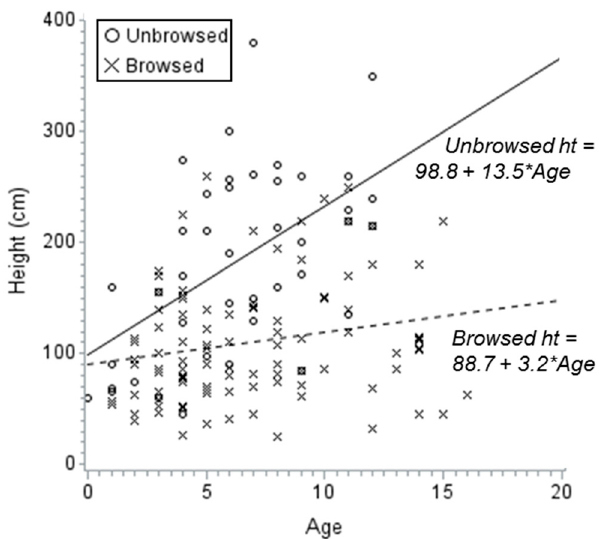
Figure 3. Height and age relationship for unbrowsed (solid line) and browsed (dotted line) aspen suckers <2.5 cm dbh. The relationship was moderately strong for unbrowsed stems ( R 2 = 0.29, P < 0.01) but weak for browsed stems ( R 2 = 0.07, P < 0.01) . Data include 41 unbrowsed and 109 browsed stems. Symbols appear darker when multiple values are in nearly the same position.